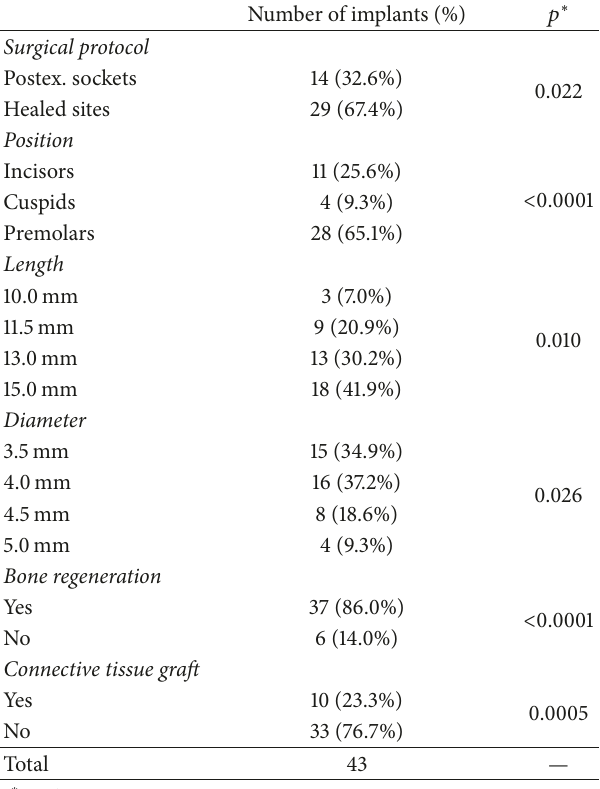
Table 2: Distribution of the implants. Number of implants